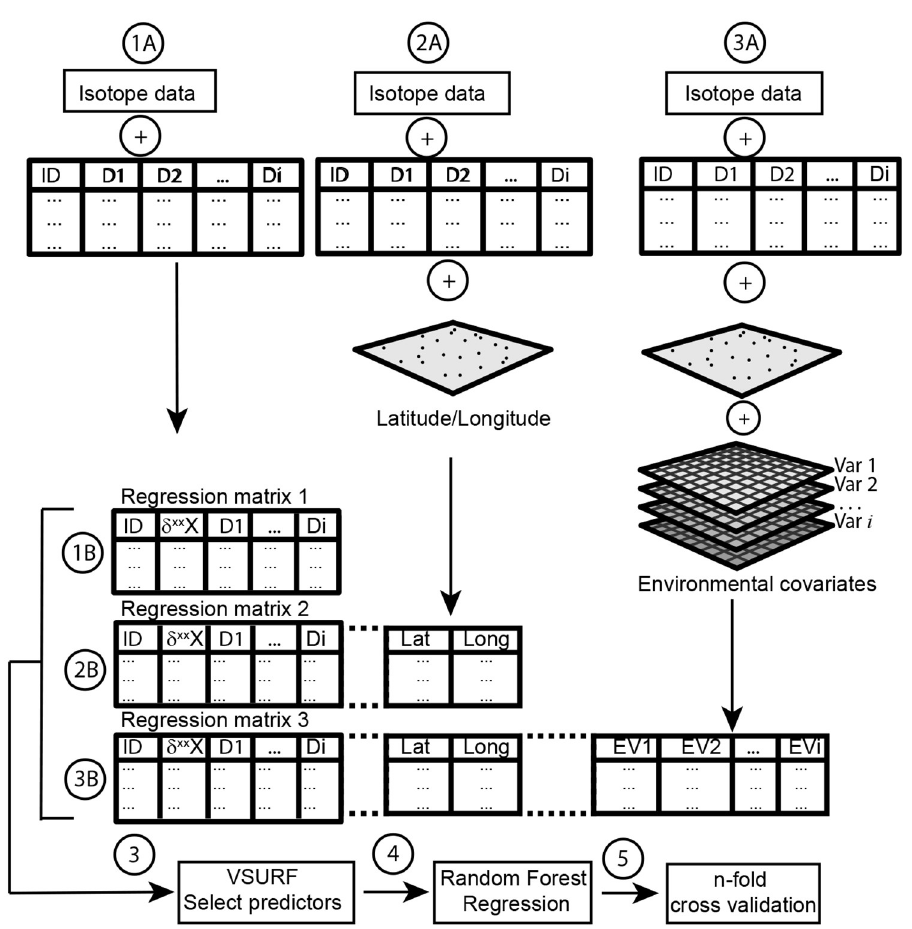
Fig 1. Multiple machine-learning regression workflow (see Materials and methods). Regression 1 includes only isotope data, dietary choices, demographic variables (S1 Table); regression 2 includes isotope data, dietary choices, demographic variables, and latitude/longitude; and regression 3 includes isotope data, dietary choices, demographic variables, and environmental covariates (Table 1).